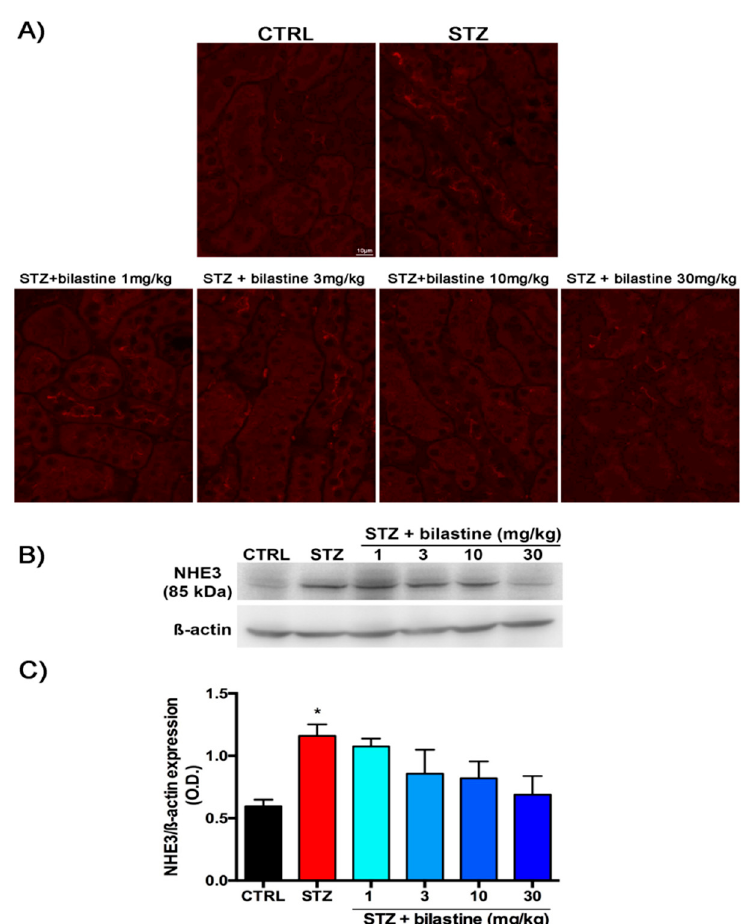
Figure 6. Effect of bilastine on NHE3 tubular expression. Micrographs representative of NHE3 expression on tubular epithelial cells determined by immunofluorescence (63 × magnification from 10 animals / group) ( A ). Representative radiograph of NHE3 expression in kidney tissue determined by immunoblotting ( B ). Densitometric analysis of NHE3 expression determined by immunoblotting analysis. Expression levels, normalized to β‐ actin, are expressed as the mean ± S.E.M. of 5 animals/group; * p < 0.05 vs. CTRL, # p < 0.05 vs. STZ ( C ).